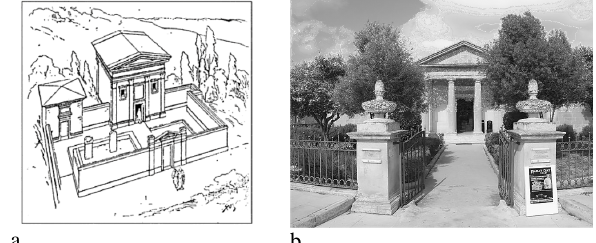
Figure 4. References for the reconstruction of the monumental building: a) Hypothesis by Christian Carl Friedrich Hülsen presented in an axonometric sketch; b) Malta, Domus Romana. Reconstruction around the archaeological findings of the temple with an underground crypt and outdoor triclino (I century).